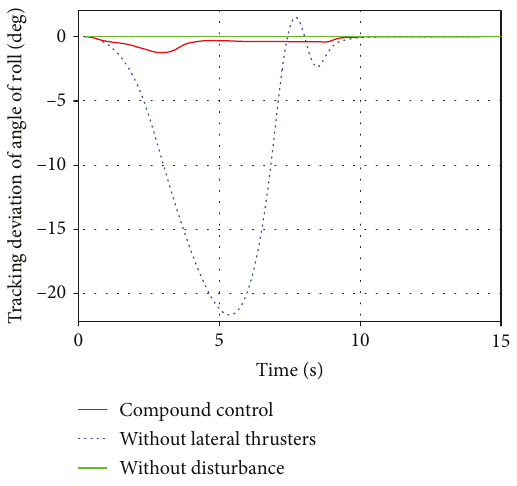
Figure 4: Tracking deviation of angle of roll in the initial stage of launch.